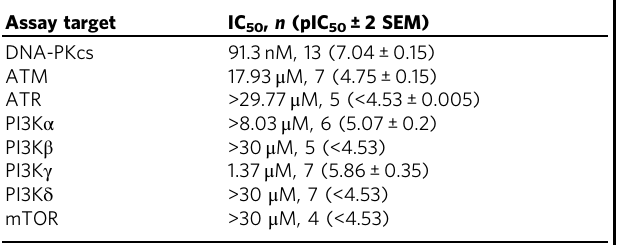
Table 1 Cellular pharmacology of AZD7648 Assay